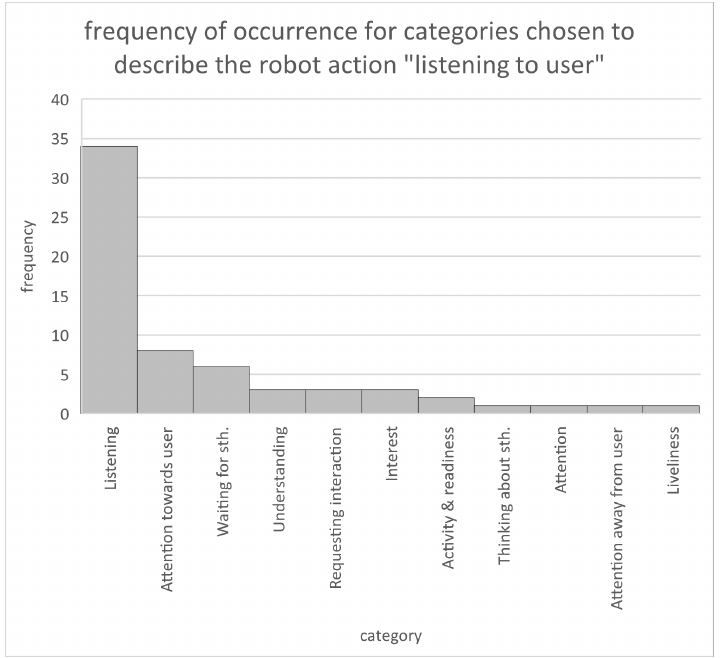
Figure 7. Overview of the frequencies of occurrence for the categories that were chosen to describe the behavior displayed by the robot for the action “listen to user”.